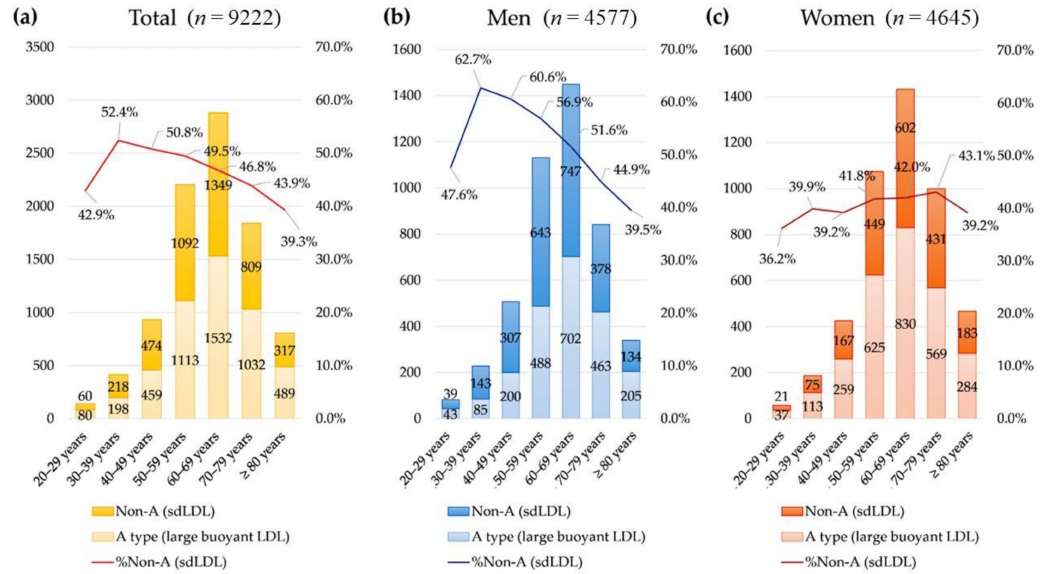
Figure 3. The prevalence of the small dense LDL predominant non-A phenotype (mean LDL particle size < 268 Å) ( a ) in the total population, ( b ) in men, and ( c ) in women.